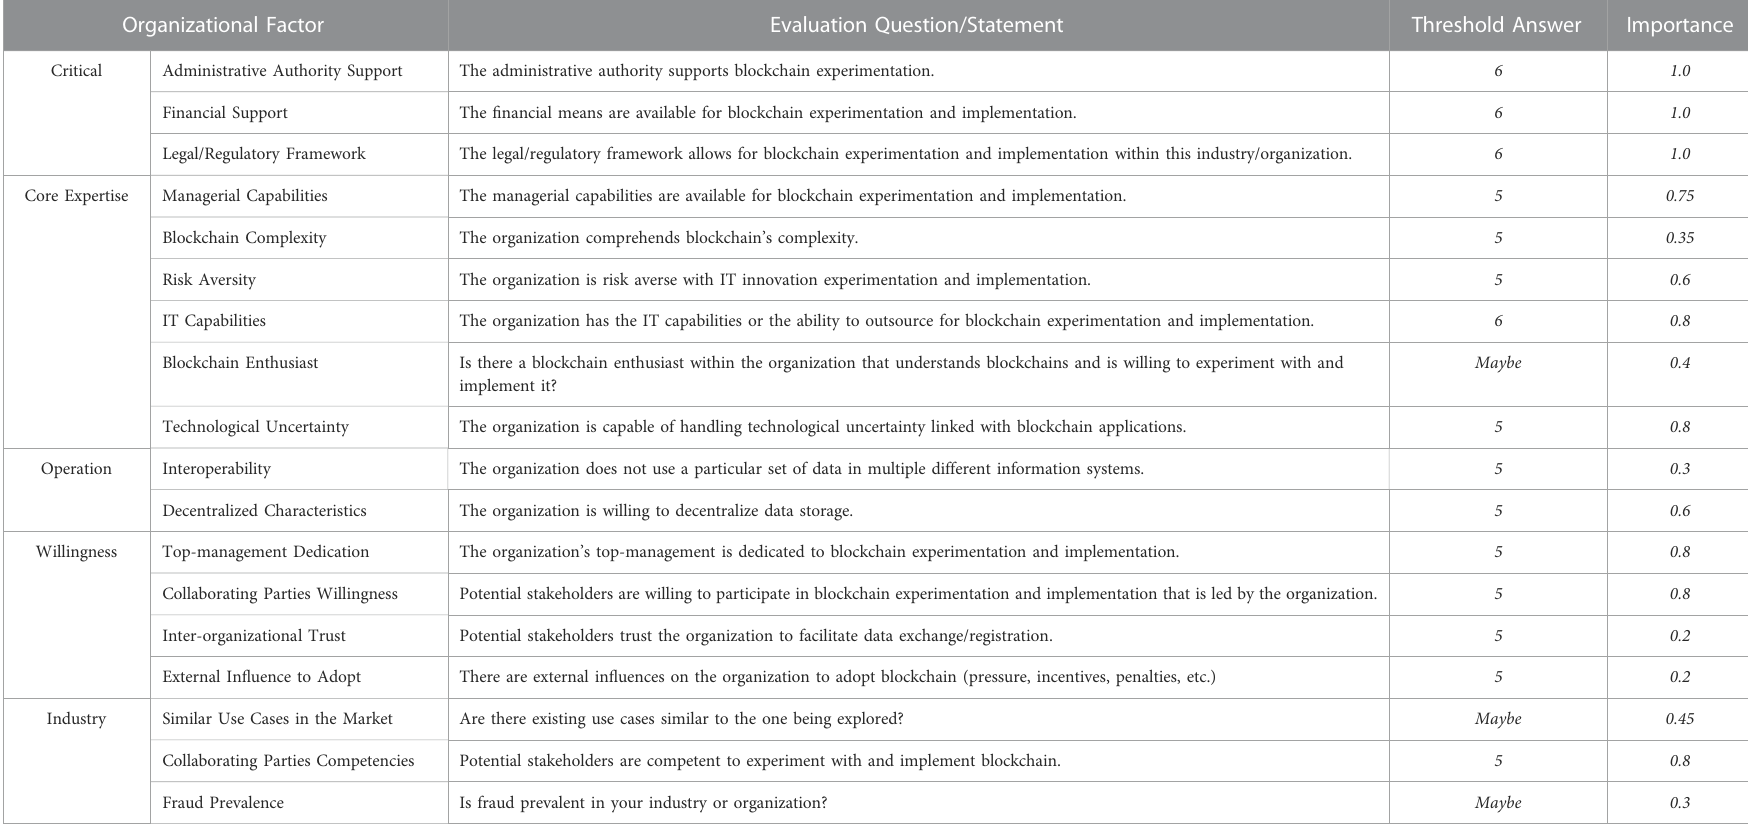
TABLE 6 Organizational Factor Evaluation Questions and